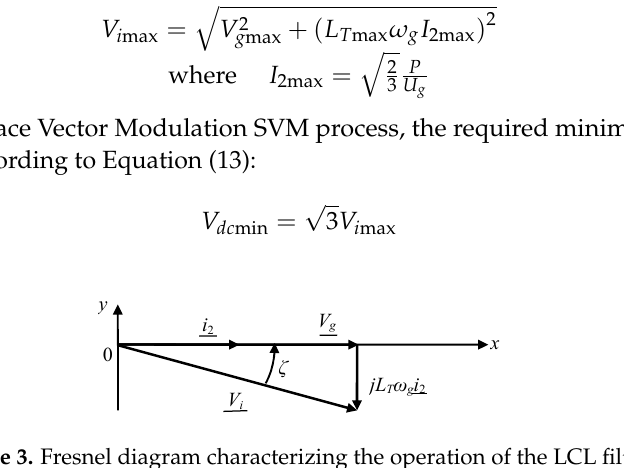
Figure 3. Fresnel diagram characterizing the operation of the LCL filter.